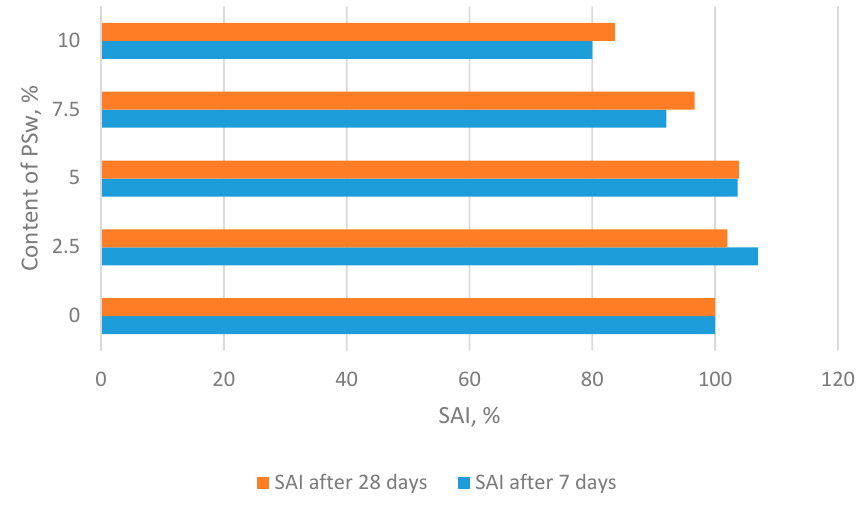
Figure 2. Strength activity index (SAI) dependence on PSw content.